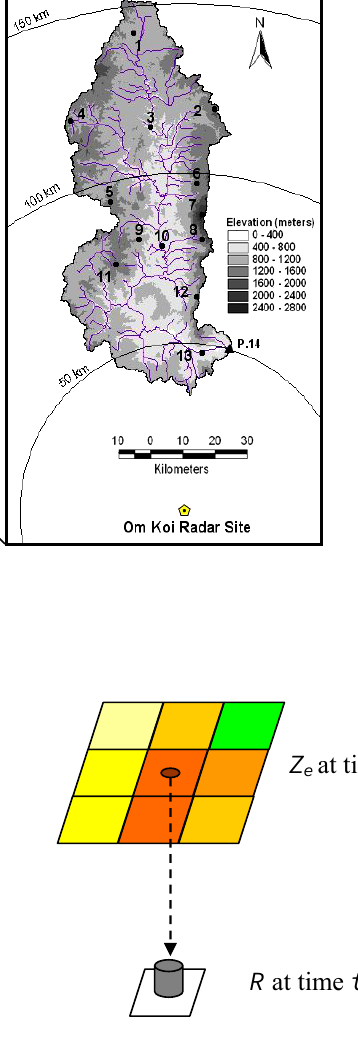
Fig. 2. The traditional Z e − R matching method